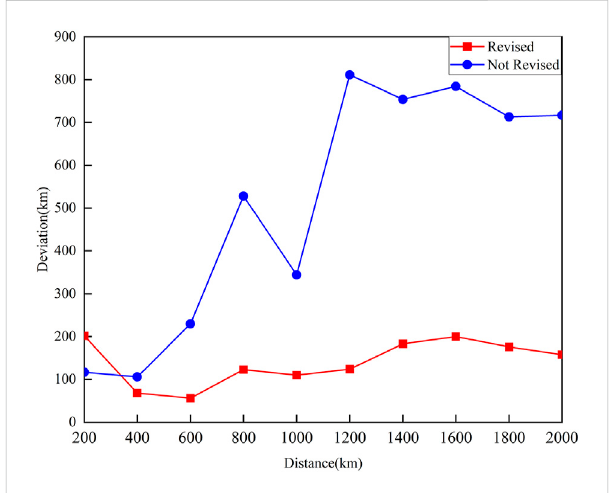
FIGURE 6 Comparison of the mean deviations of the revised and not revised methods at different distances.